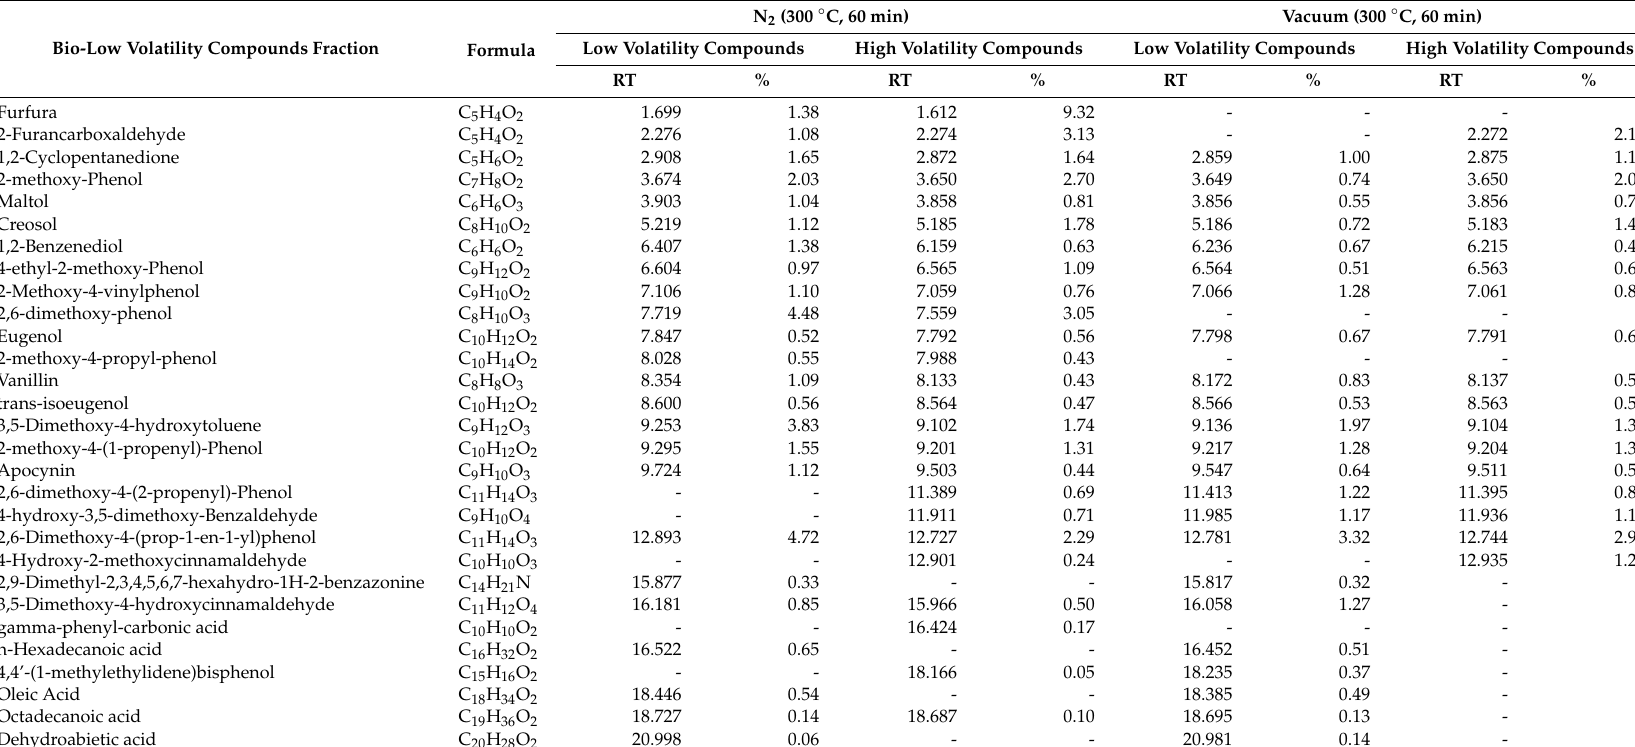
Table 3. Relative peak area distribution of the main products for biomass in GC / MS with vacuum and nitrogen systems.